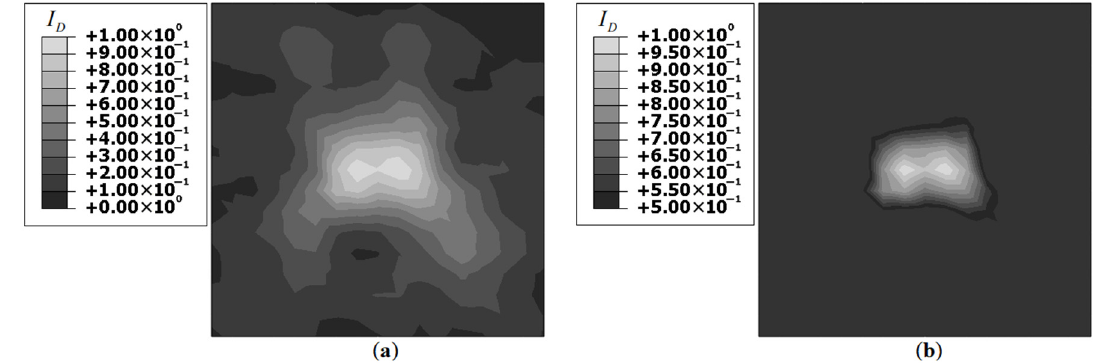
Figure 15. Benchmark iFEM results of I D for Damage Case-1 (5% noise) using: ( a ) no threshold, and ( b ) threshold = 0.5.